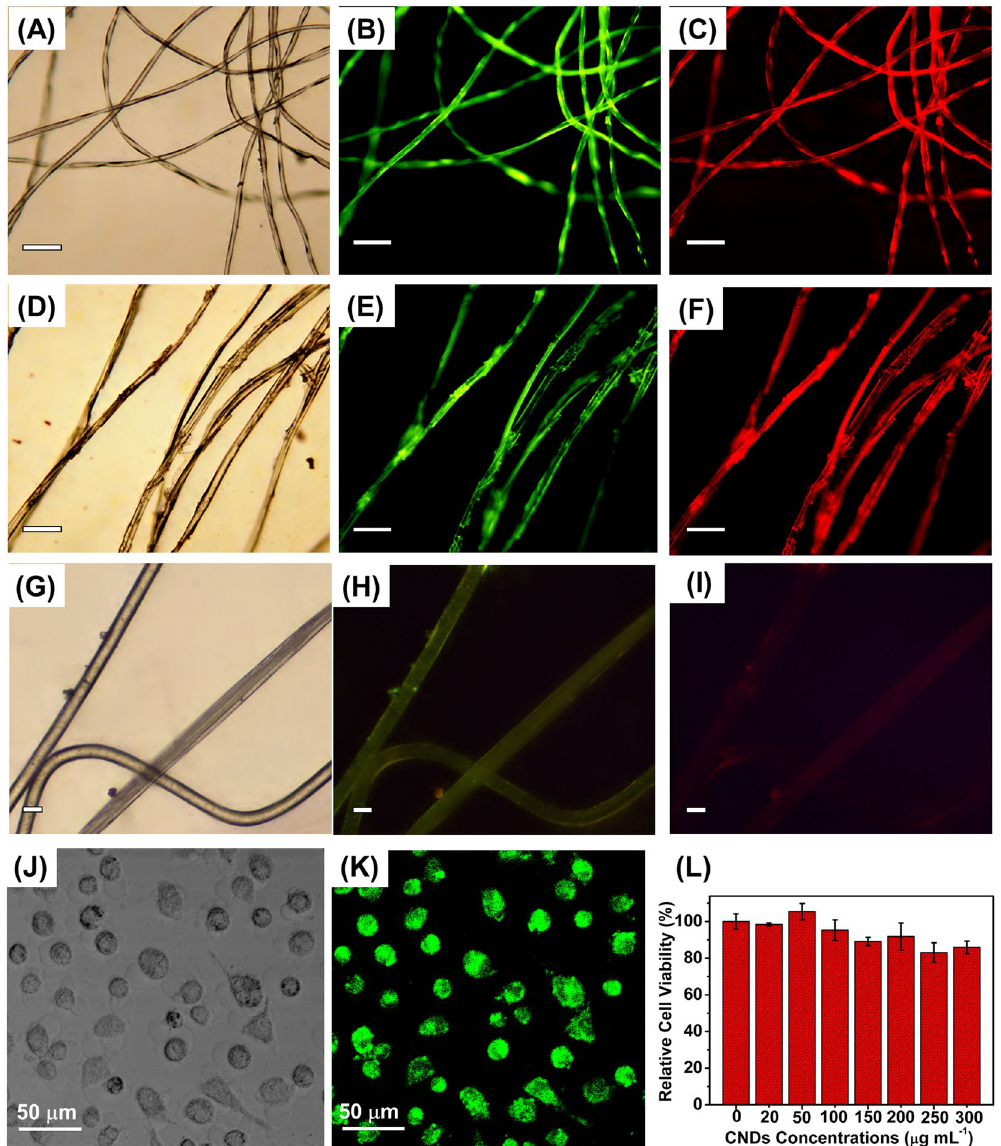
Figure 5. ( A ) Bright field and ( B , C ) fluorescence images of cotton fiber stained with the prepared CNDs. ( D ) Bright-field and ( E,F ) fluorescence images of silk fiber stained with the prepared CNDs. ( G ) Bright field and ( H,I ) fluorescence images of cotton fiber without being stained with the prepared CNDs. The fluorescent images were obtained at the excitation wavelengths of ( B,E ) 450–480 nm, and ( C,F ) 510–550 nm. Scale bars of A–I : 100 μ m. LSCM images of HeLa cells incubated with 100 μ g mL − 1 CNDs for 24 h at 37 ◦ C: ( J ) bright field images, ( K ) fluorescence images at excitation wavelength of 488 nm. ( L ) Cell viability of HeLa cells (n = 3, mean ± S.D.) after being incubated with CNDs at various concentrations (0, 20, 50, 100, 150, 200, 250, 300 μ g mL − 1 ,